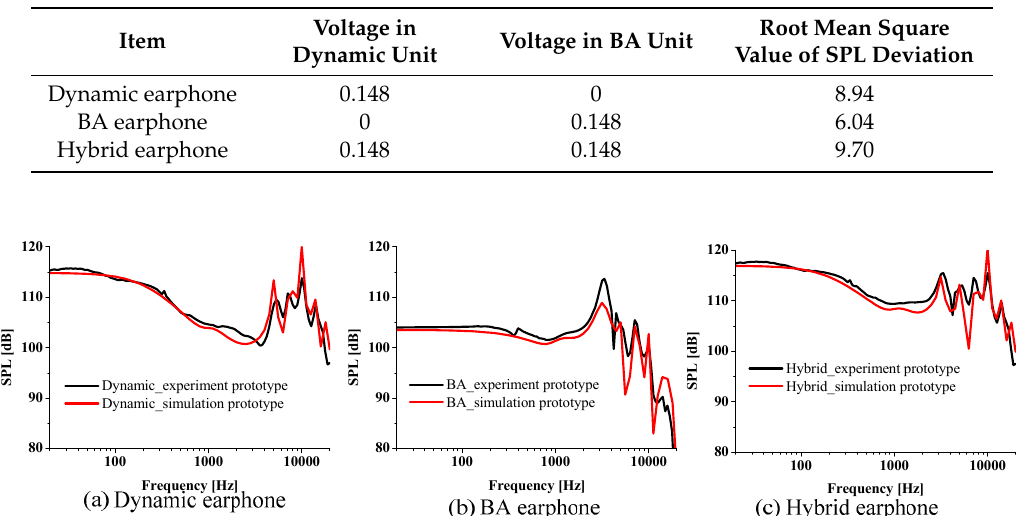
Figure 11. Sample and experiment setup. Table 2. Earphone definition and root-mean-square value of sound pressure level (SPL) deviation.